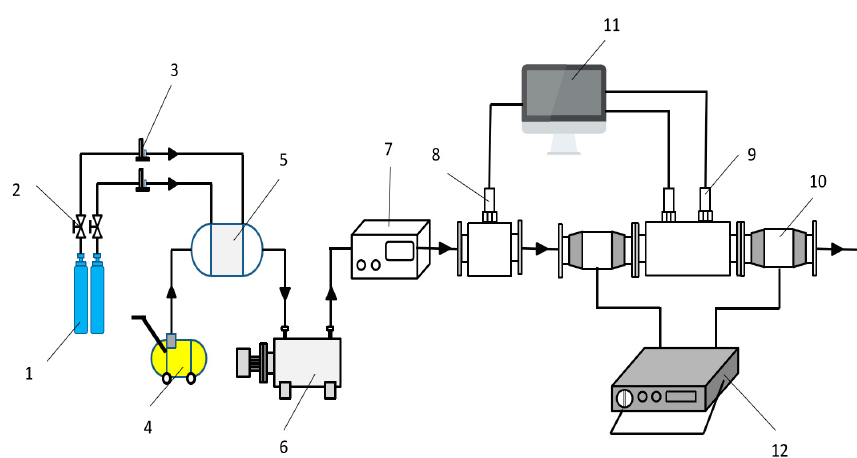
Figure 9. Simulation test bench for charge performance of particles. (1) Nitrogen cylinder (2) Throttle valve (3) Flow meter (4) Air compressor (5) Pressure stabilizing cylinder (6) Pipeline heater (7) Particle generator (8) Pressure sensor (9) Leakage current particulate matter sensor (10) Faraday cylinder (11) Computer (12) Digital charge meter.